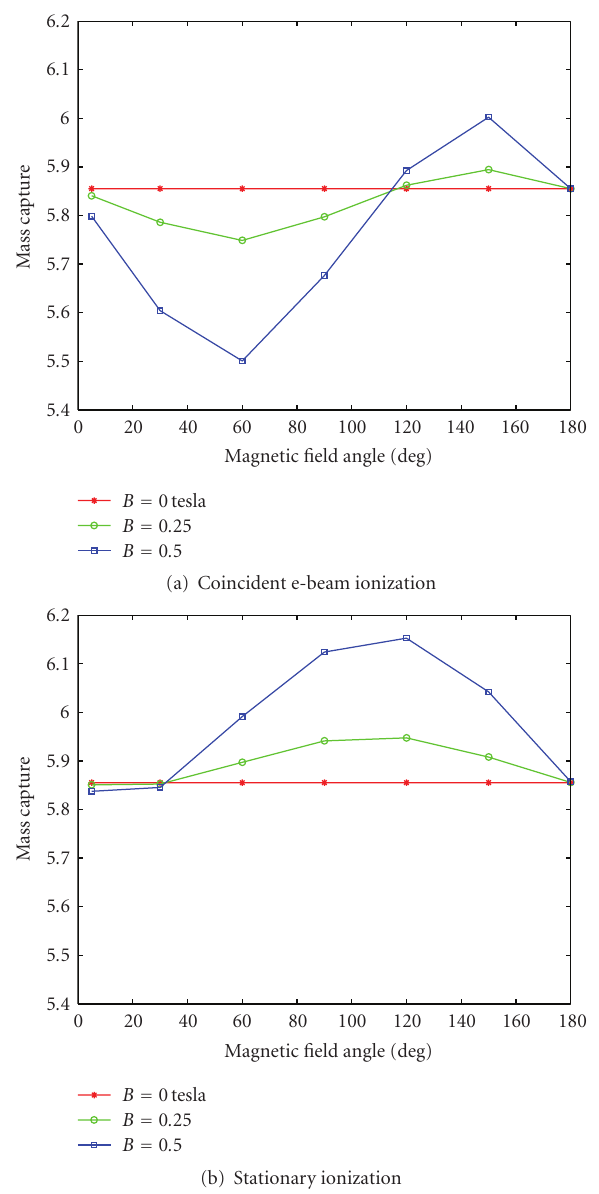
Figure 11: Mass capture for inlet with conductivity σ = 2.0 mho/m. Results are shown for (a) coincident ionization and (b) stationary ionization.